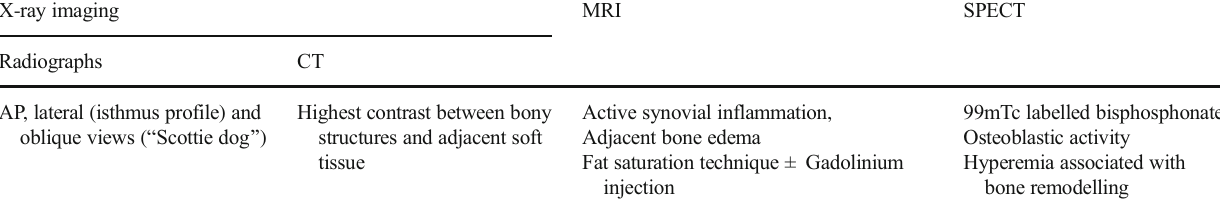
Main imaging findings in various imaging modalities X-ray